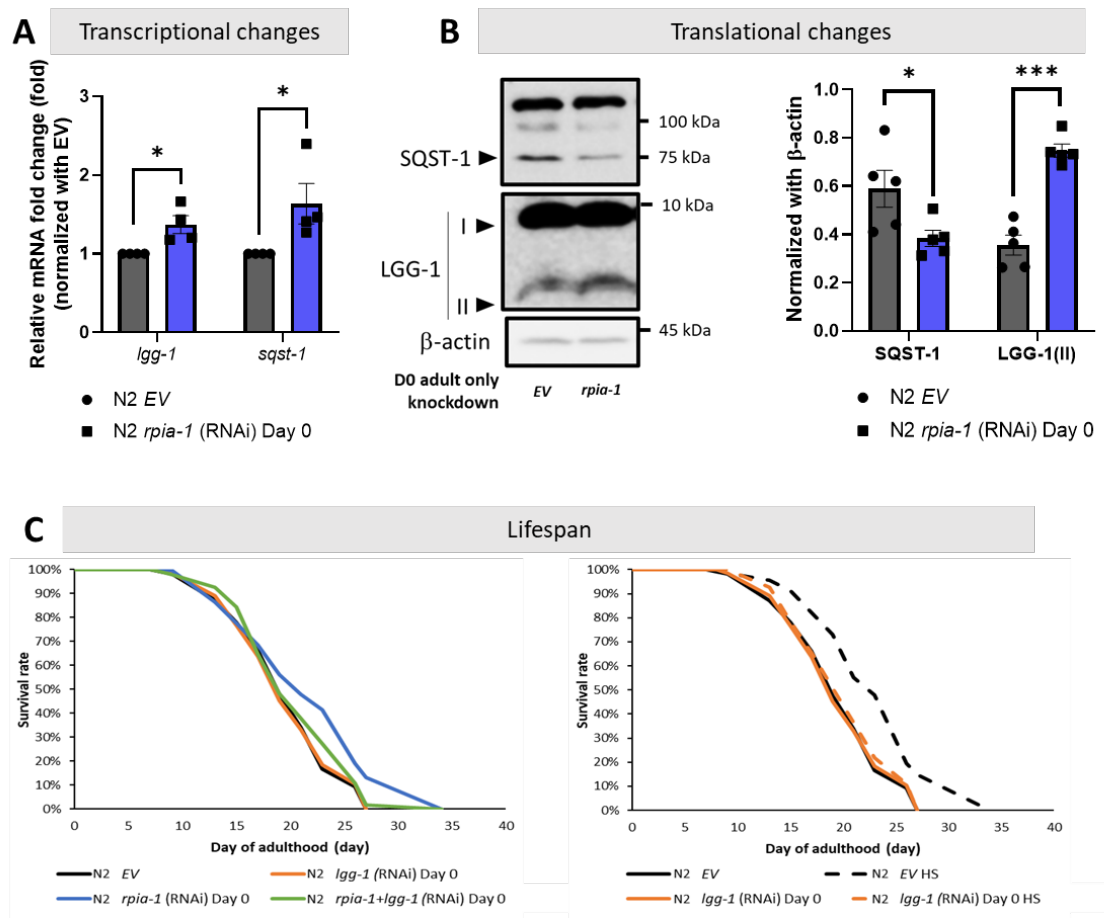
Figure 5. Knockdown of rpia-1 prolongs lifespan by inducing autophagy. ( A ) By conducting qPCR analysis, the transcriptional levels of autophagy-related marker genes lgg-1 and sqst-1 were signifi- cantly induced when rpia-1 was ubiquitously reduced (*, p < 0.05; ***, p < 0.001, by t -test). ( B ) By Western blotting analysis, significantly reduced SQST-1 level and increased LGG-1-II level were detected upon rpia-1 knockdown ubiquitously (*, p < 0.05; ***, p < 0.001, by t -test). ( C ) (In left panel) Ubiquitous knockdown of rpia-1 from day 0 of adulthood (blue solid line) extended the mean lifespan by 11.6%, whereas the knockdown of lgg-1 from day 0 of adulthood (orange solid line) which suppresses autophagy, ablated the rpia-1 -mediated lifespan extension (green solid line) (***, p < 0.001, by log-rank test). (In right panel) Knockdown efficiency of lgg-1 on lifespan assay was confirmed by lgg-1 knockdown before hormetic heat shock treatment in wild-type N2 strain, which was reported to extend lifespan through the induction of autophagy. Hormetic heat shock treatment prolonged the mean lifespan by 19.2% (black dashed line), but the lifespan extension was ablated by concomitant lgg-1 knockdown (orange dashed line) (***, p < 0.001, by log-rank test). According to our data and previous findings, the knockdown of rpia-1 / Rpi extends lifespan associated with elevated NADPH levels in C. elegans and in Drosophila [22], and RPIA knockdown induces autophagy in human colorectal cancer cells [25]. The AMPK pathway and TOR pathway have been shown to regulate the autophagy process in previ- ous studies [51]. These pathways not only regulate lifespan but are also involved in energy homeostasis, which may be related to NADPH generation [52]. Hence, to assess whether rpia-1 knockdown may prolong lifespan by activating AMPK and inhibiting TOR, we con- ducted Western blotting analyses, by detecting p-AMPK and p-S6K as the markers for AMPK and TOR pathway activity, respectively, in rpia-1 RNAi knockdown and control